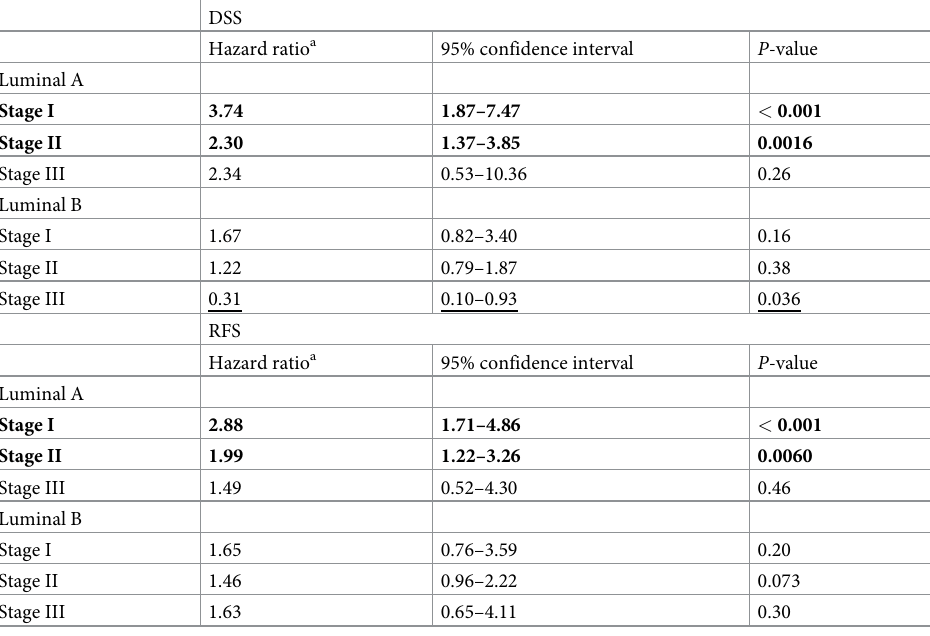
a SLC20A1 high group’s hazard ratio to SLC20A1 low group adjusted using age as a confounding factor as estimated using Cox proportional hazard model. Significant differences are shown in bold and underlined indicates good